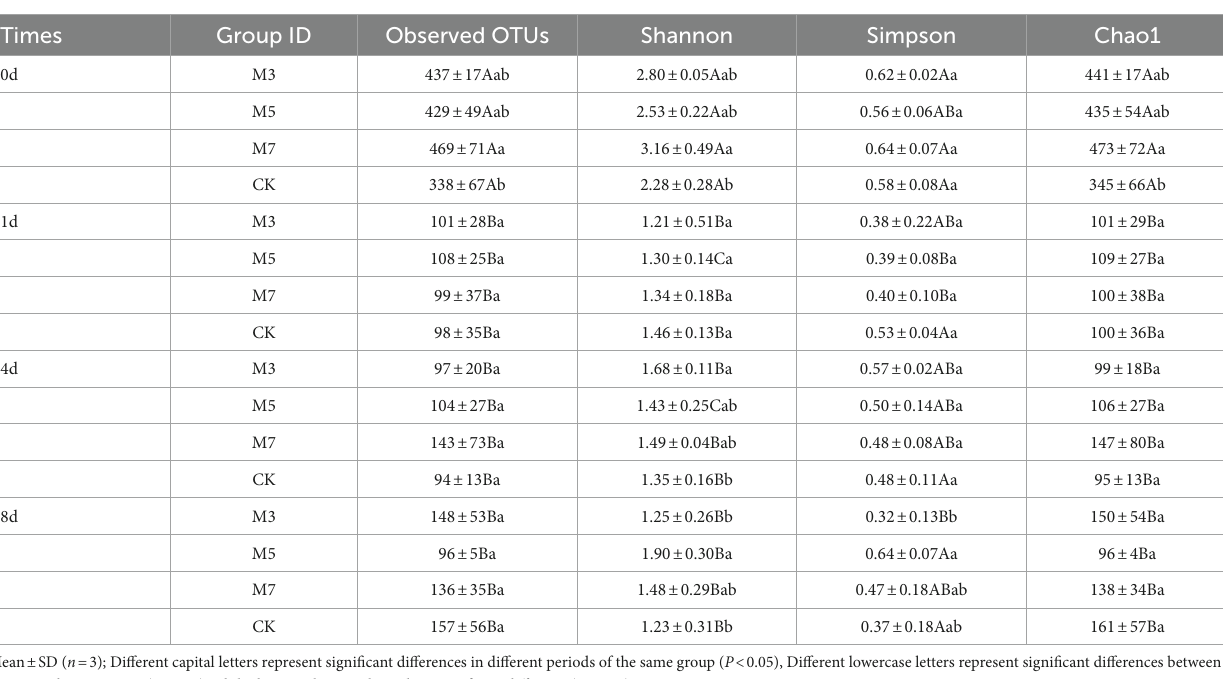
TABLE 4 Different estimator indexes for alpha diversity in samples.